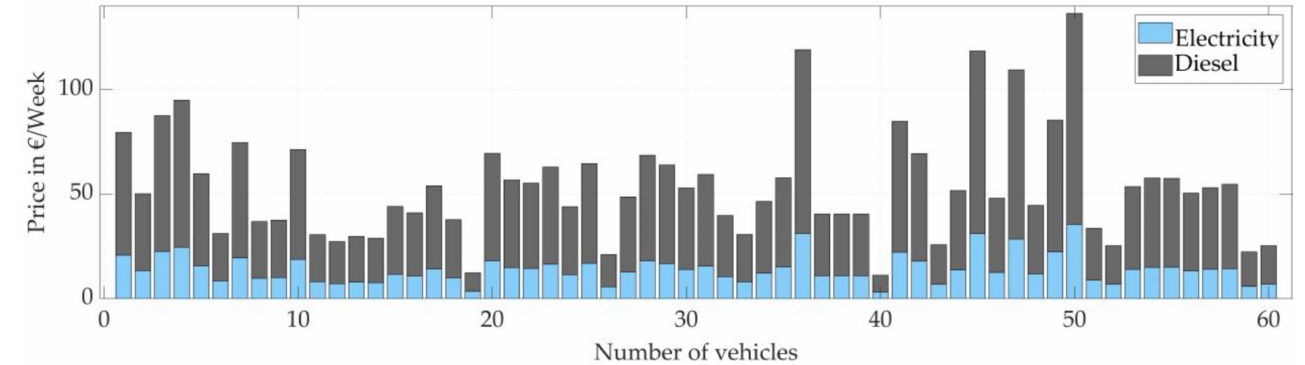
Figure 13. Comparison of diesel and electricity purchase cost for a vehicles fleet.